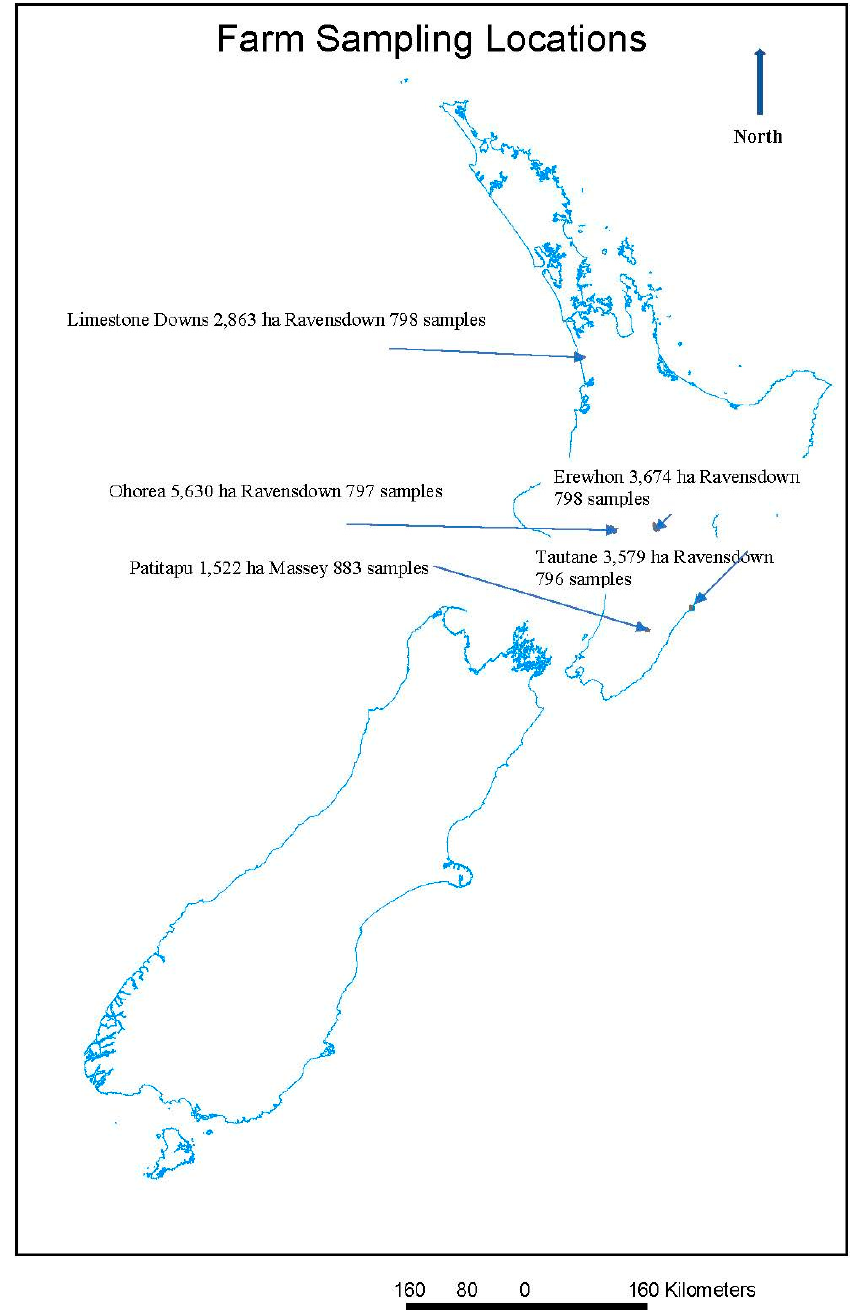
Figure 2. Location and name of farms where samples were collected. The sampling body (Ravensdown Ltd, or Massey University) the size of the farm and number of samples taken.